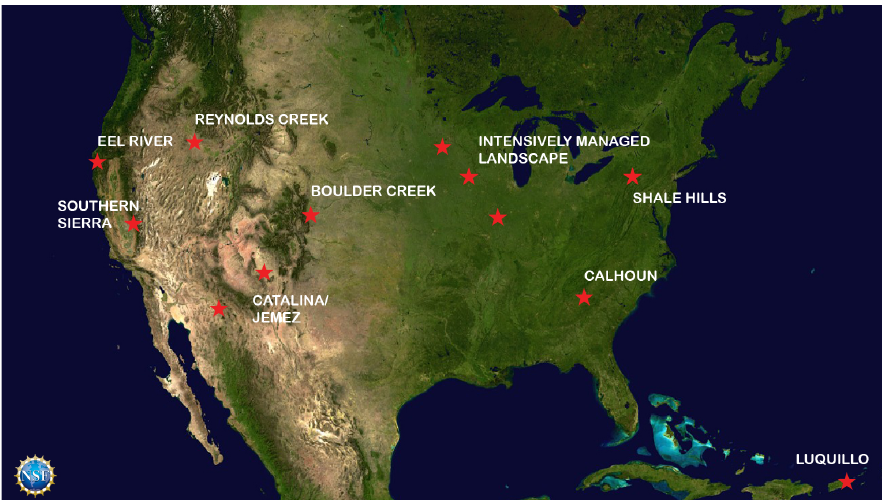
Figure 2. The current network of nine critical zone observatories funded in the United States to investigate all aspects of the critical zone. Abbreviations used in Table 2 include Eel River (ER), Southern Sierra (SS), Jemez–Catalina (JC), Boulder Creek (BC), Reynolds Creek (RC), Intensively Managed Landscapes (IML), Susquehanna Shale Hills (SH), Calhoun (CL), and Luquillo (L).